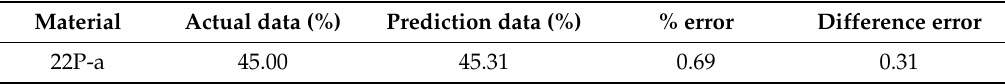
Table 7. Validation value and percentage error.